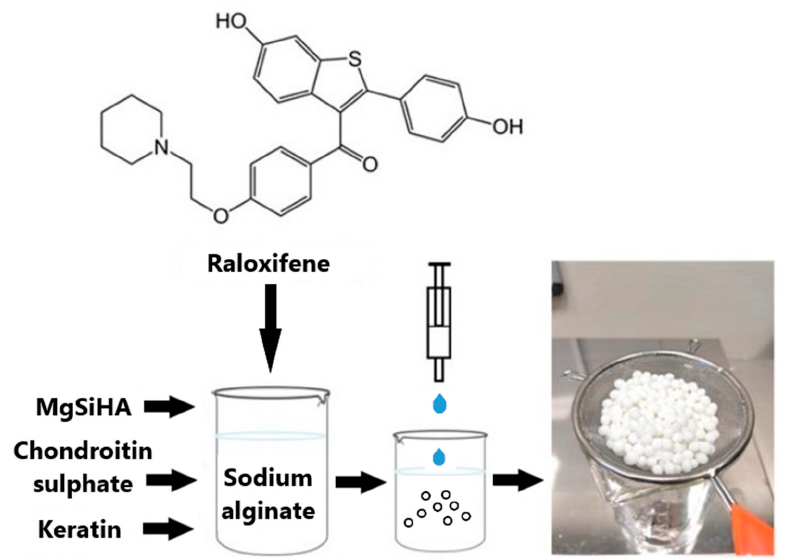
Figure 3. The synthesis procedure of Mg, Si-hydroxyapatite/alginate beads for controlled release of raloxifene. Reprinted from [45], International Journal of Molecular Sciences 2021.